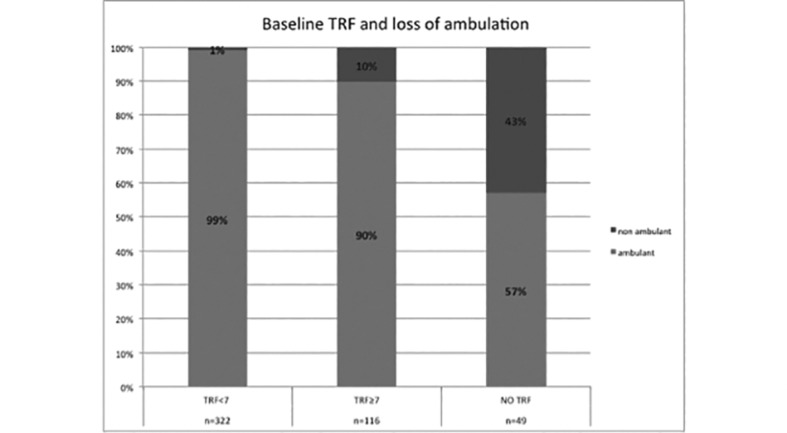
Percentage of patients losing ambulation in subgroups subdivided according to TRF performance.